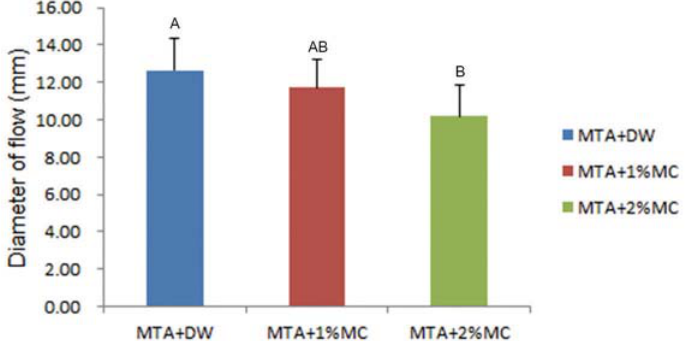
decreased when compared to MTA 2